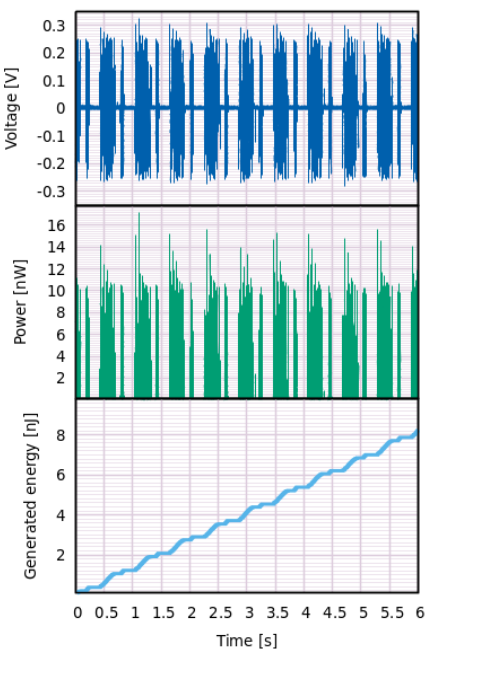
(cid:82) T P ( t ) dt = 0